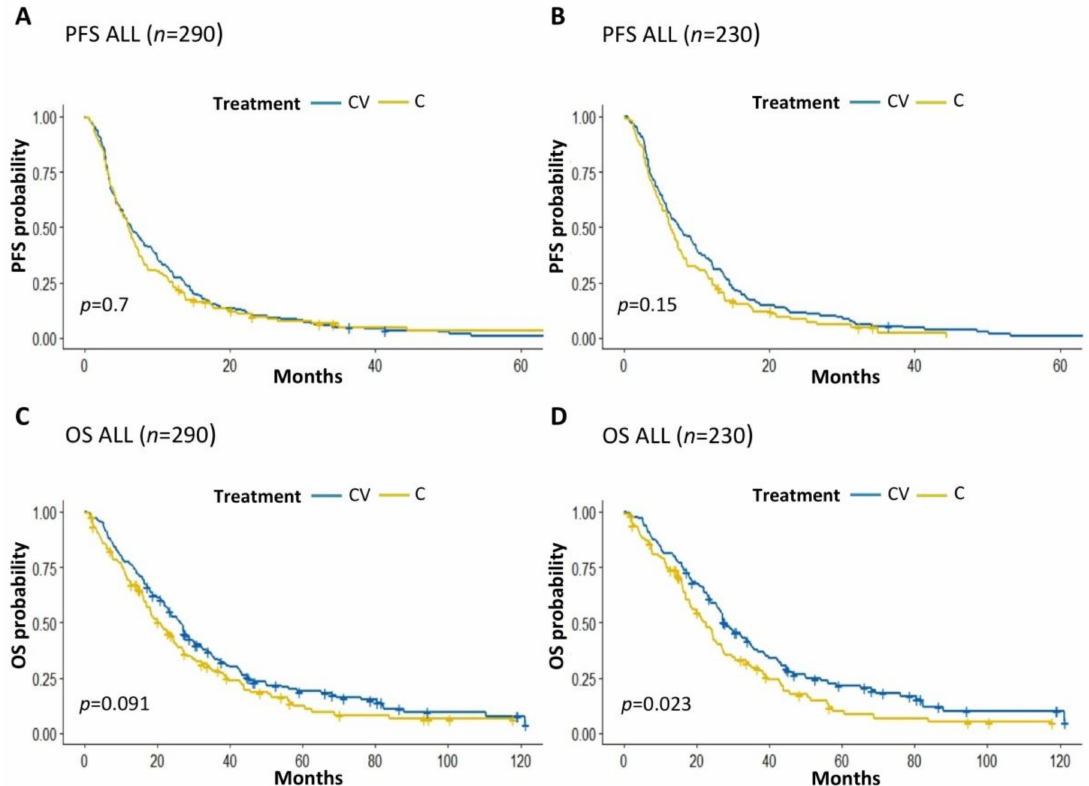
Figure 1. ( A , B ): Kaplan Meier curves of PFS in the whole population of enrolled patients treated with CV vs. C ( A ) or in HR + BC patients treated with CV vs. C ( B ). ( C , D ): Kaplan Meier curves of OS in the whole population of enrolled patients treated with CV vs. C ( C ) or in the subgroup of HR + BC patients treated with CV vs. C ( D ). C: capecitabine; V: vinorelbine; PFS: Progression-free survival; OS: Overall survival. The + symbol indicates patients censored at the time of data cut o ff and